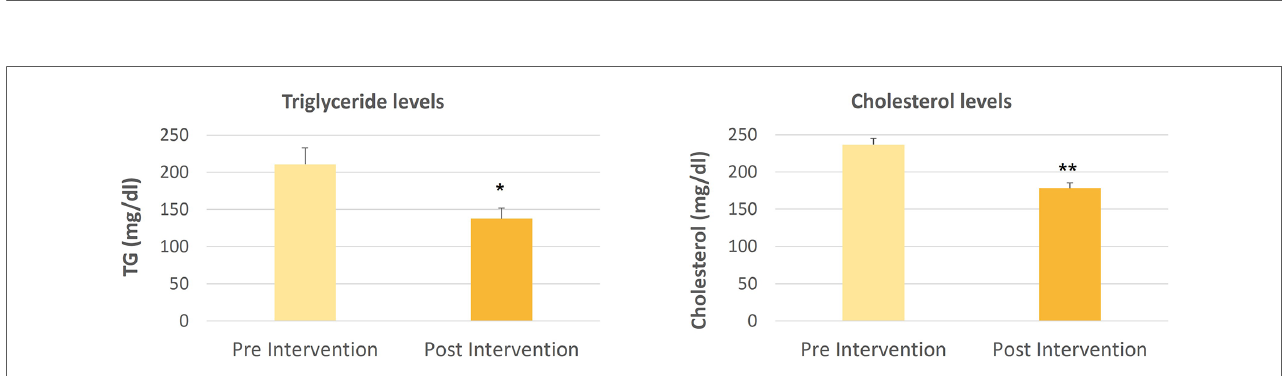
FIGURE 2 Triglyceride and cholesterol levels comparison in cricket players ( n =10) between pre and post-intervention period of 21 days supplementation with Spirulina, * p <0.05, ** p <0.01, *** p